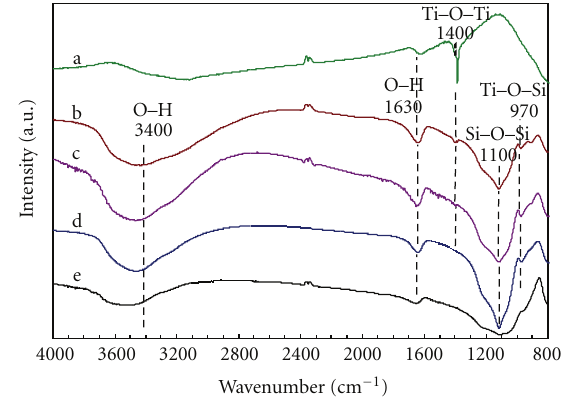
Figure 3: FTIR spectra of TiO 2 , SiO 2 , and ST serial composite ma- terials heated at 100 ◦ C for one hour: (a) TiO 2 , (b) ST 1.5, (c) ST 3, (d) ST 5, and (e) SiO 2 .